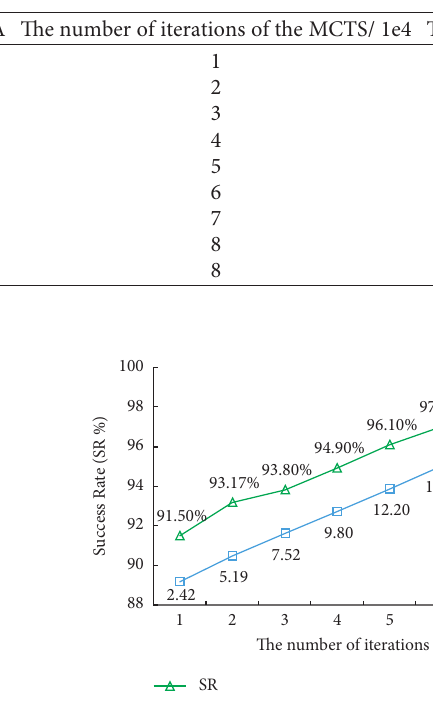
Table 4: The design of the success rate and mean computing time for CR.